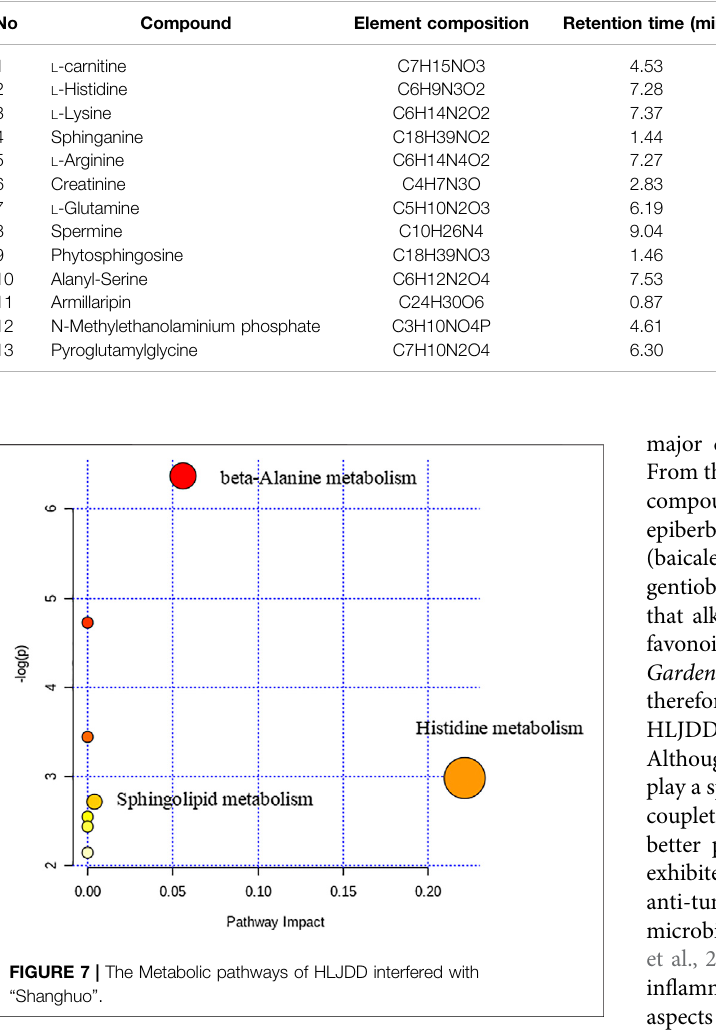
TABLE 2 | Identi fi cation of biomarkers in the HLJDD intervention group and the oral disease group.